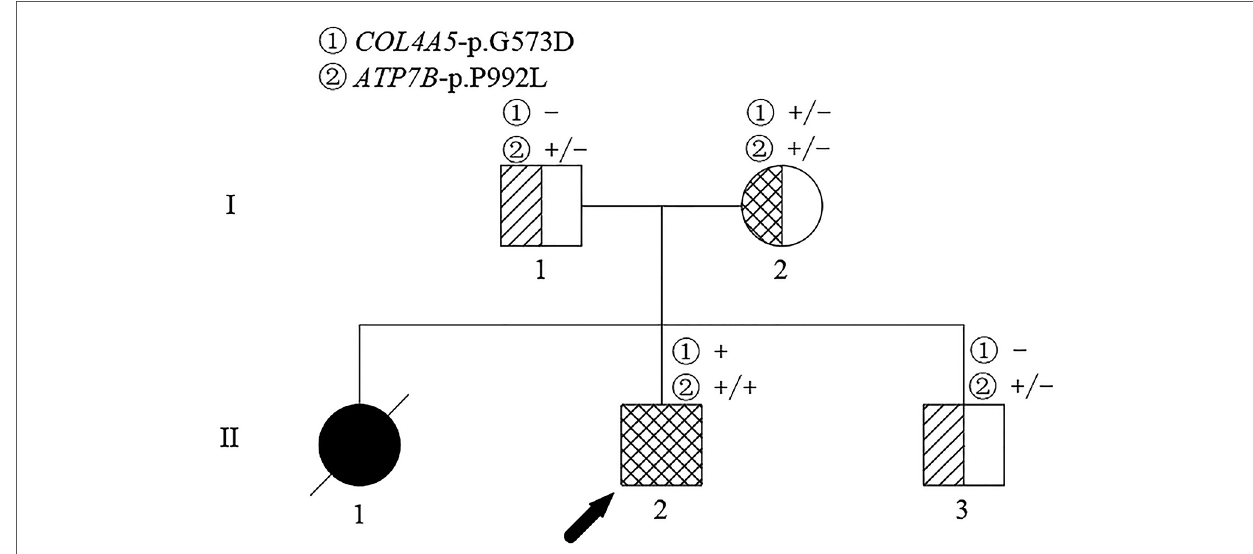
FIGURE 1 Pedigree of the family affected. The arrow identi fi es the proband. The crossed symbol indicates the deceased